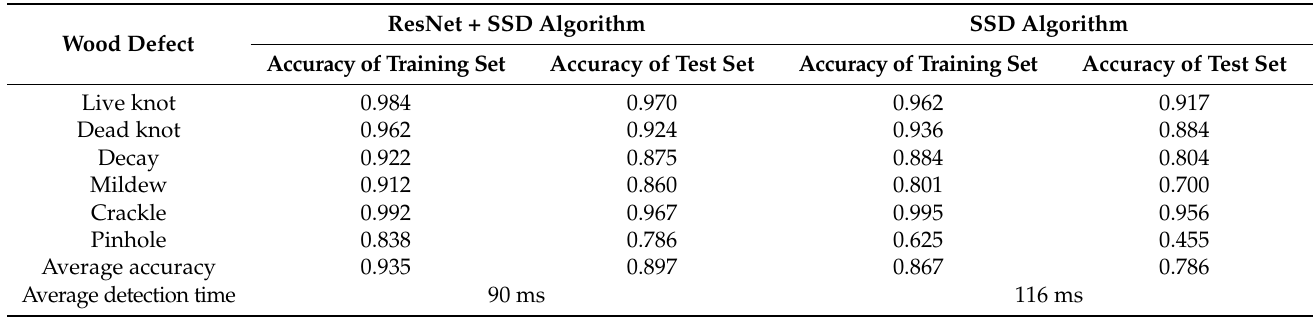
Table 2. Detection results of the detection